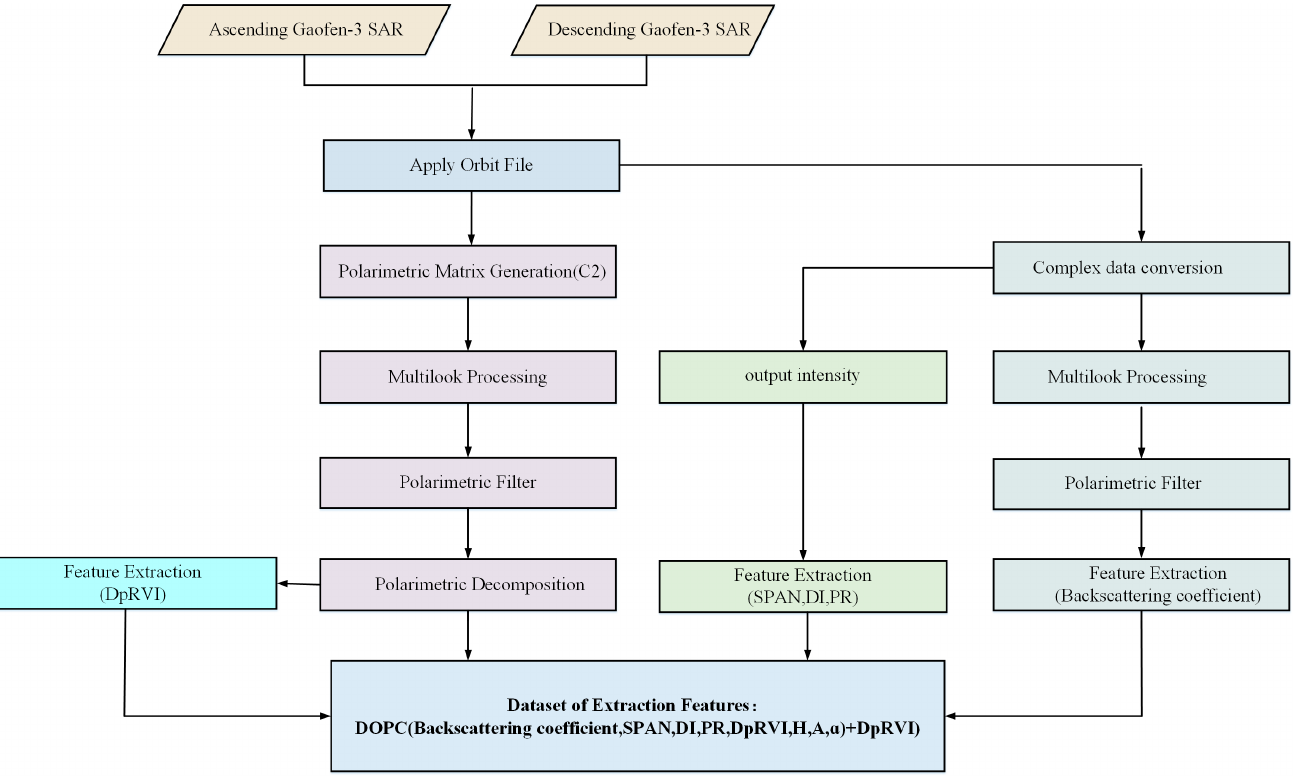
Figure 8. Frame of Features Extraction.